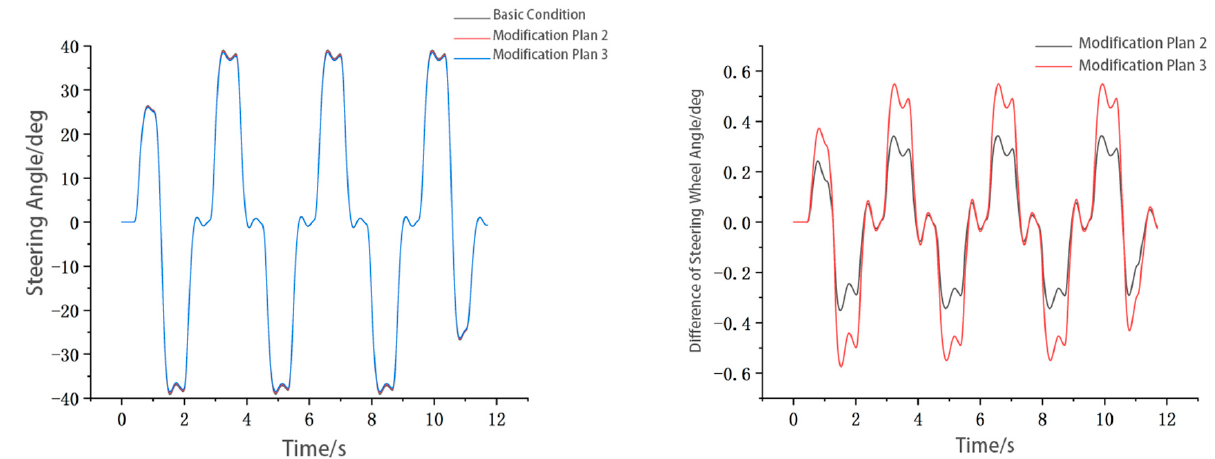
Figure 26. Comparison curve of steering-wheel angle and difference of snaking test.